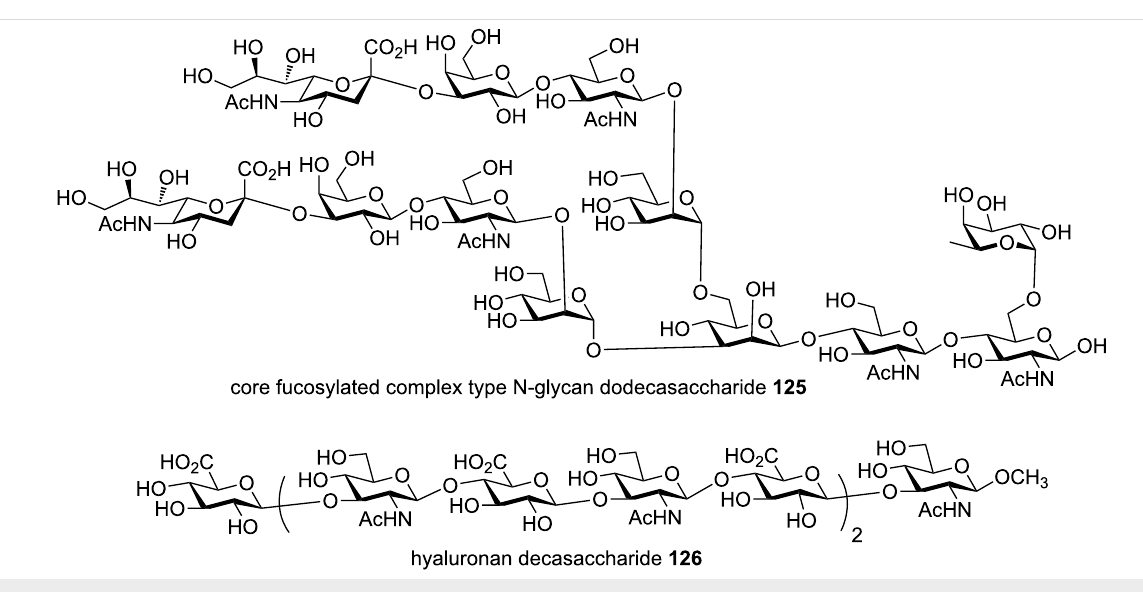
sized bearing a ketone tag at the reducing end using building blocks 83 , 150 and 151 following the preactivation-based one- pot protocol (Scheme 22). After completion of the synthesis,